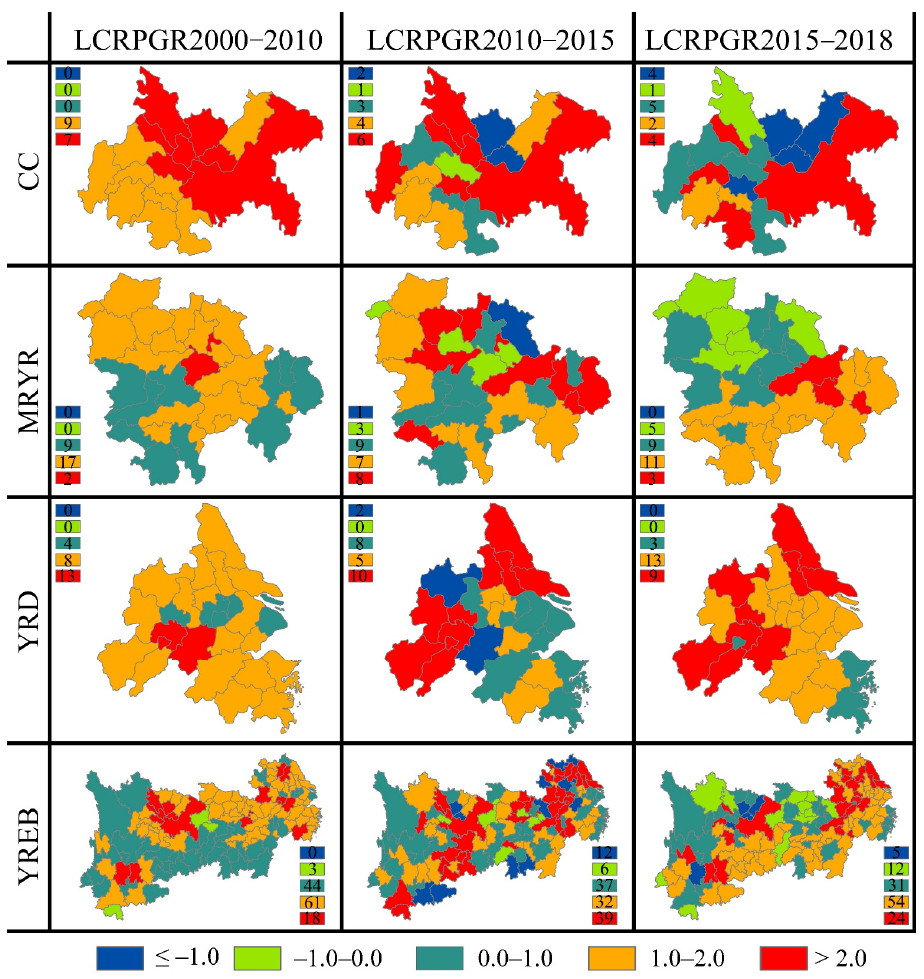
Figure 4. Spatial patterns of the LCRPGR values across CC, the MRYR, the YRD, and the YREB in 2000–2010, 2010–2015, and 2015–2018. A positive value for LCRPGR indicates an increase in built-up area and population over the period, while a negative value indicates a decrease. The numbers in the legend represent the count of prefecture-level cities of each classification.